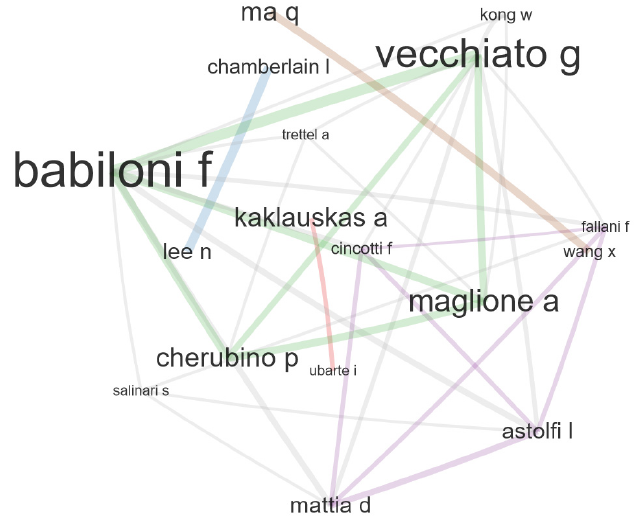
Figure 2. Authors’ Figure 2. Authors’ collaboration.